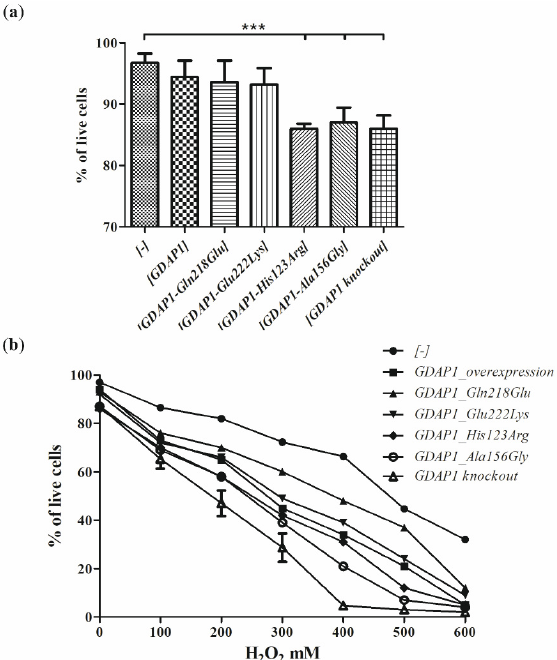
Figure 3. The viability and sensitivity to H 2 O 2 of the SH-SY5Y cell line expressing the GDAP1 mutant alleles. Trypan blue dye exclusion test of GDAP1 ( GDAP1_overexpression ) or GDAP1 missense variants expressing cells and GDAP1 knockout cells compared with the control cells with empty vector [-] ( a ) from standard growth conditions ( b ) after treatment with H 2 O 2 . The results are means from three repetitions ± standard deviations; Statistical significance was determined using one-way ANOVA and Dunnett correction with *** p < 0.001 vs. empty vector